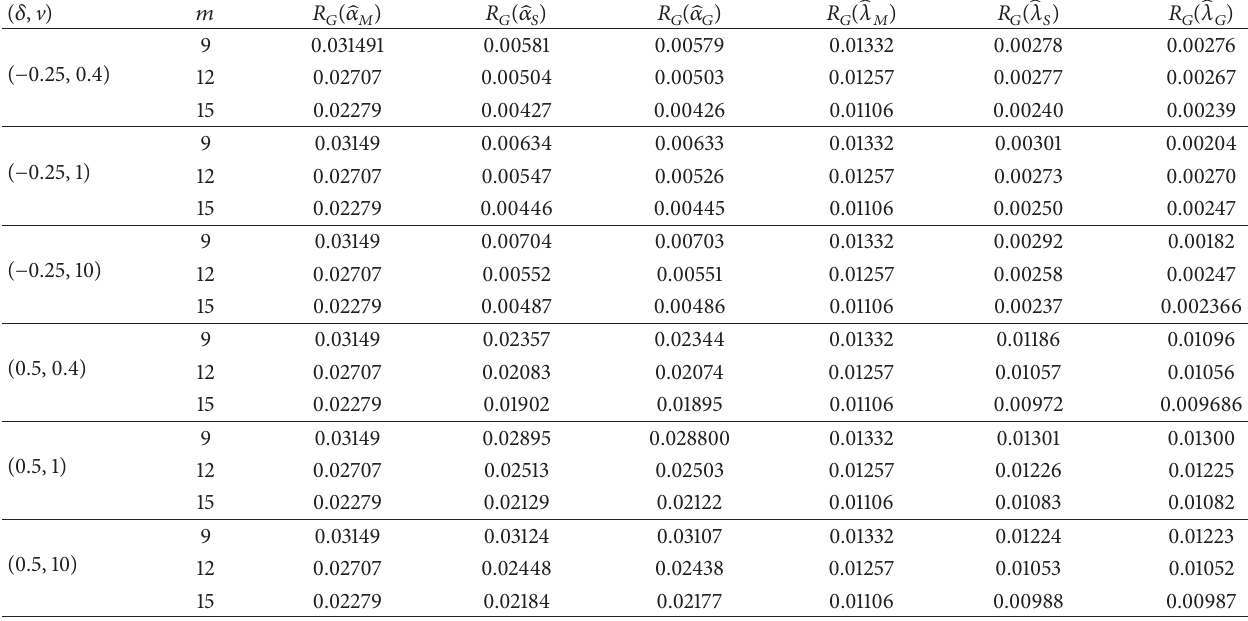
Table 4: Risks of estimators of 𝛼 and 𝜆 under GELF for fixed, 𝑛 = 15 , 𝛼 = 2 , 𝜆 = 2 , and 𝑝 = 0.5 .